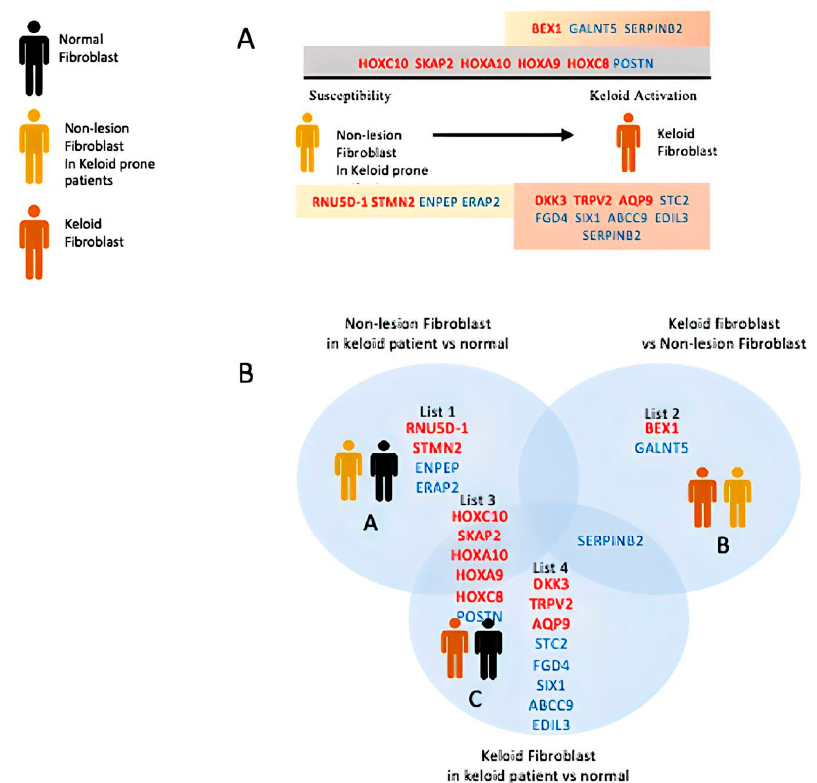
Figure 2. DEG of keloid, susceptible, and control. ( A ) The first row depicts exclusive gene expression of keloid/susceptible (list2); second gray row depicts the common underlying difference between keloid/susceptible with control (list3); and the bottom row (list1, 4) depicts the exclusive distinction of keloid/susceptible with control. ( B ) Venn diagram illustrating the above relationships.